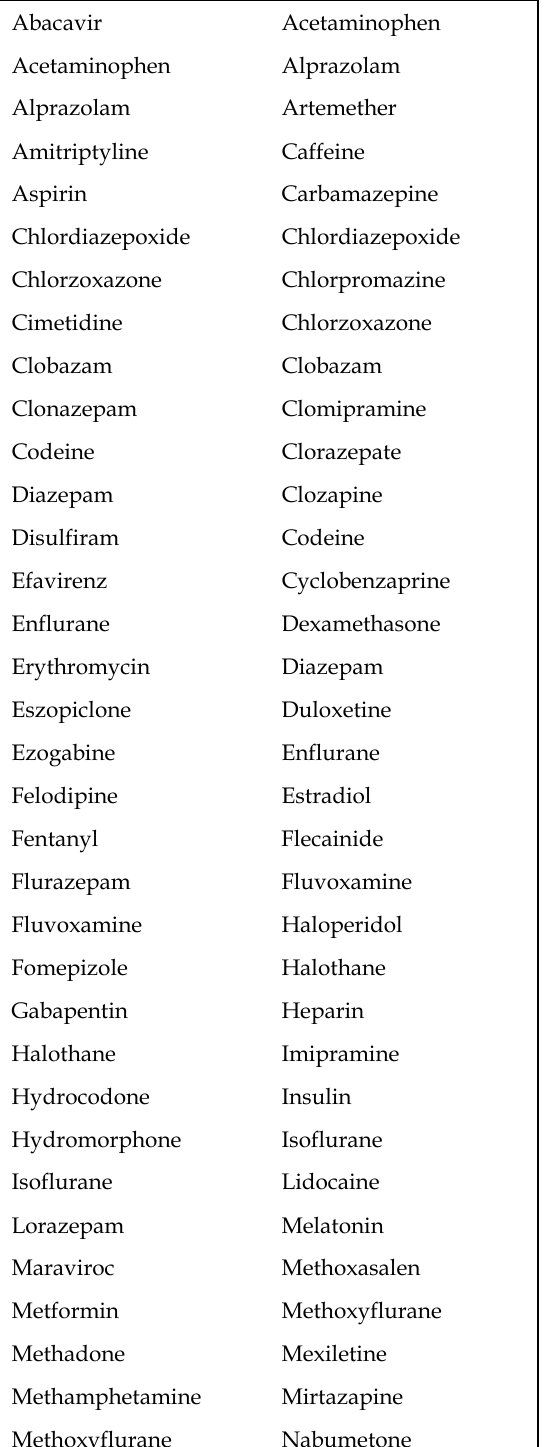
Table 1 Sample of interactions for evaluation Drug-ethanol